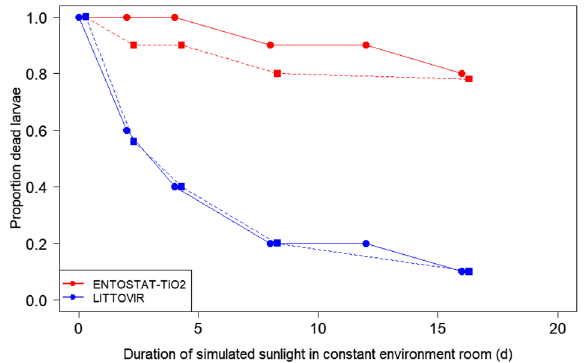
Figure 2. Efficacy of LITTOVIR and ENTOSTAT-TiO 2 -encapsulated NPV formulations following exposure to simulated sunlight up to 16 days in a constant environment room on tomato and cabbage plants. Cabbage = circles, solid line; Tomato = squares, dashed line. Symbols are staggered slightly for clarity. Larval mortality in the control group (dH 2 0 only) averaged 10–20% (data not shown). The equivalent daily dose of UV is 499 kJ m −2 .